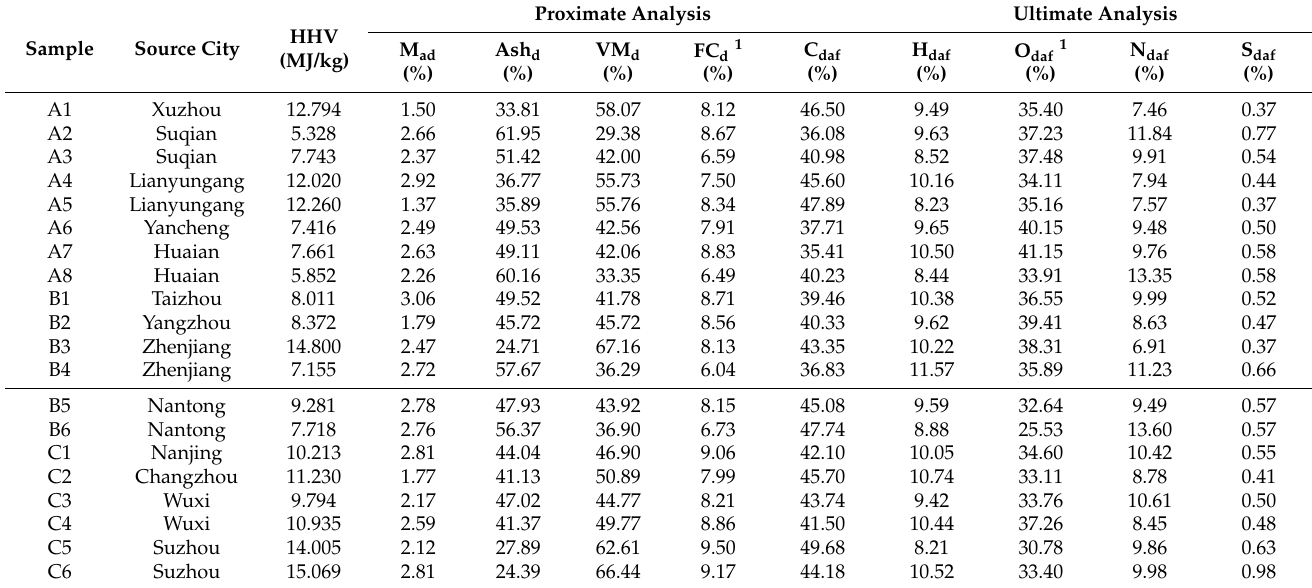
Table 1. Characteristics of sewage sludge from different wastewater treatment plants (average for each